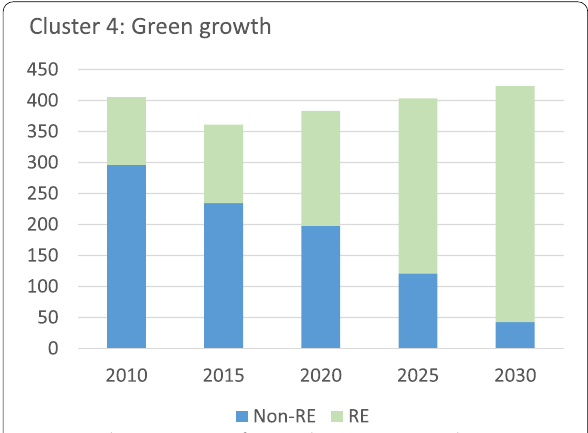
Fig. 7 Total consumption of energy between 2010 and 2030 in ‘green growth’ scenario (N.B. the total consumption was 378 TWh in 2019; 2010 and 2015 have been added